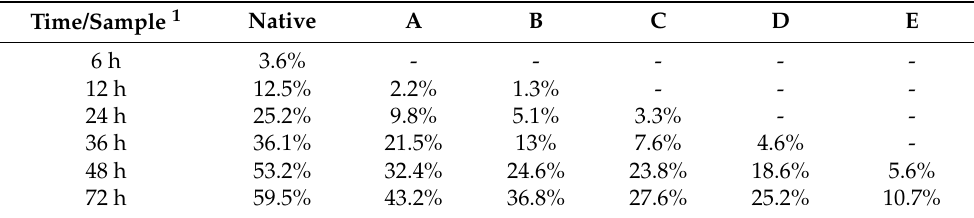
Table 1. Retrogradation of native starch and γ -HPS. Figure 5. Syneresis (%) during freeze–thaw cycles for native and γ -HPS pastes.